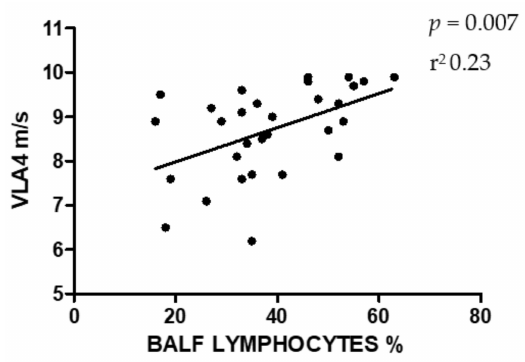
Figure 2. Results of linear regression between the percentage of BALF lymphocytes and